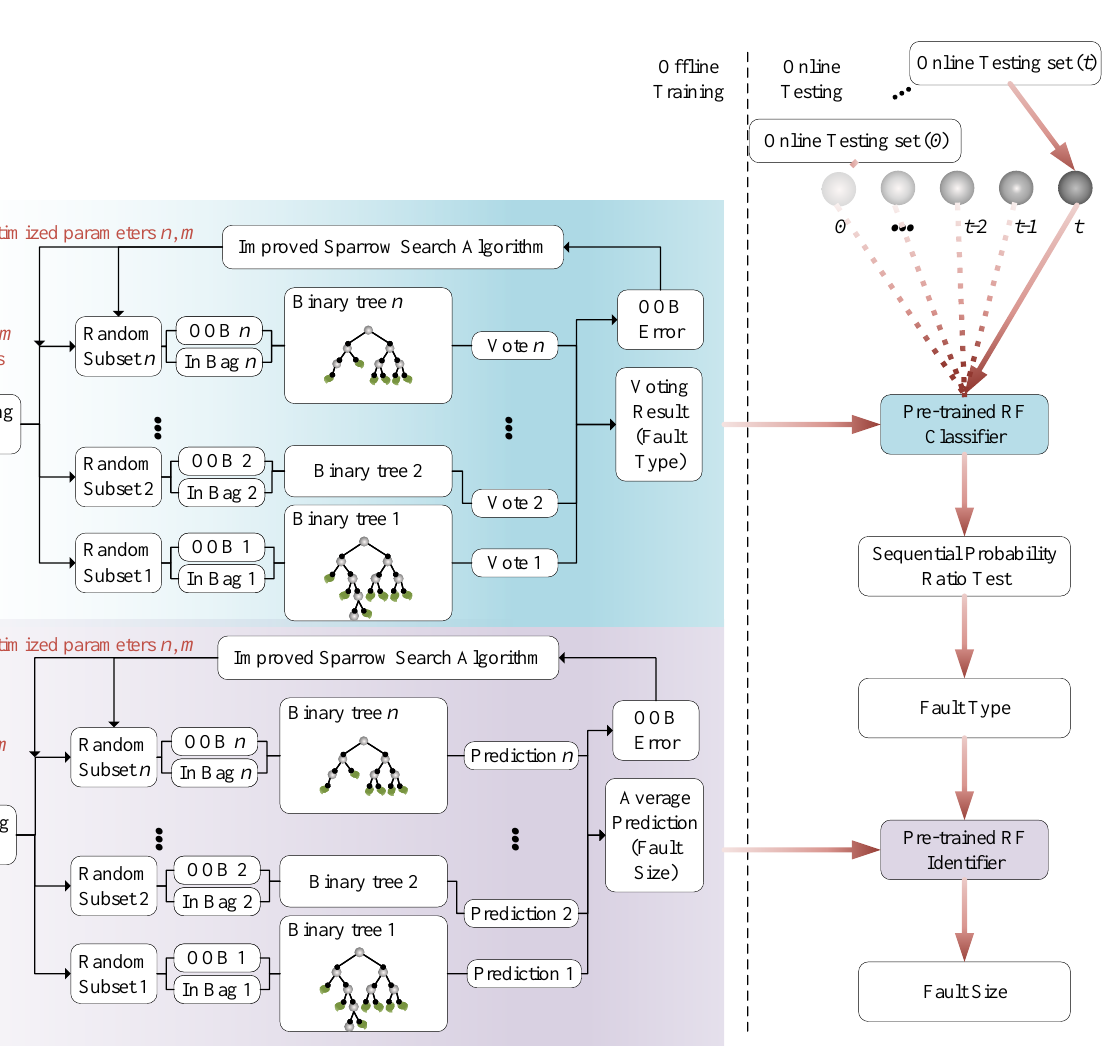
Figure 4. The flow of the sequential RF-based fault isolation and identification